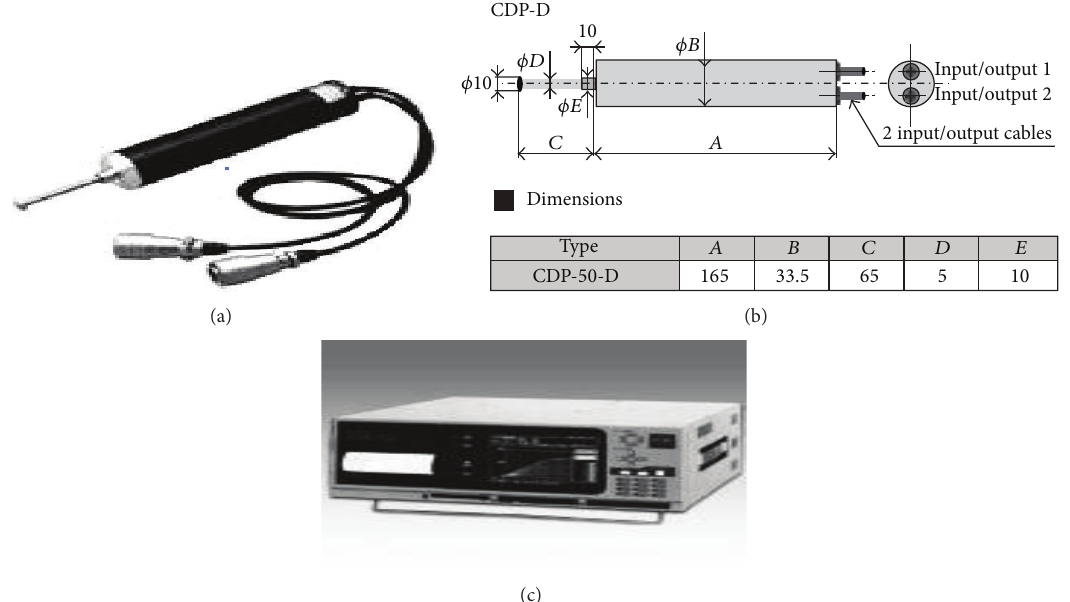
Figure 12: Transducer and data logger. (a) Displacement transducer, CDP-100, (b) dimension of displacement transducer (CDP-100), and (c) data logger, UCAM-70A.